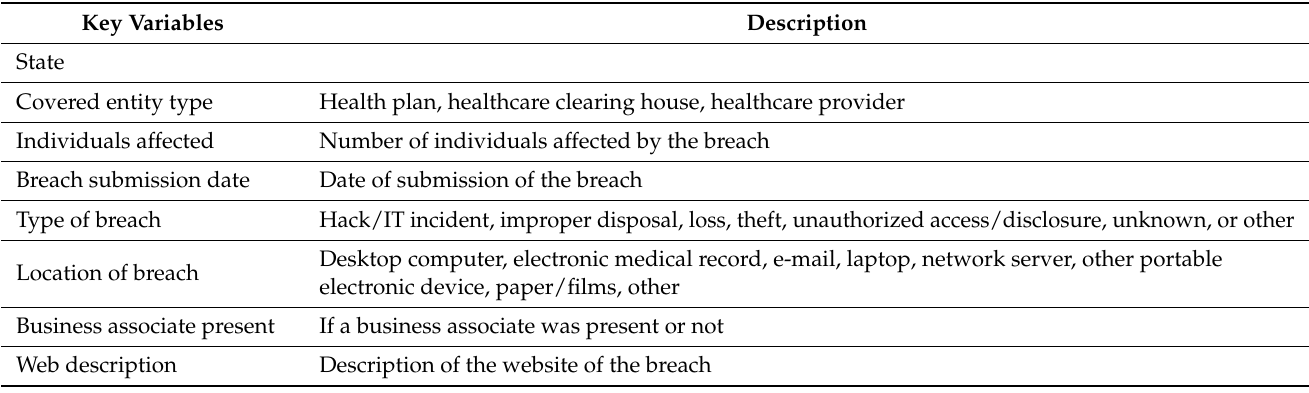
Table 1. Breach data source from the U.S. Department of Health and Human Services